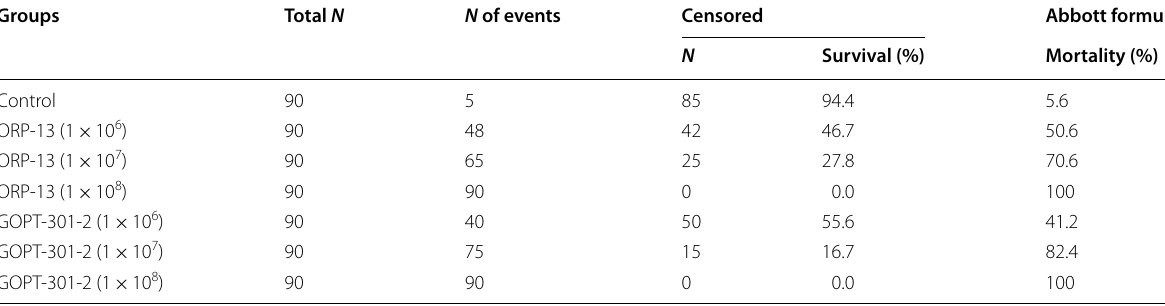
Table 2 Survival rates of Malacosoma neustria larvae and mortality confirmed by Abbott formula Groups Total N